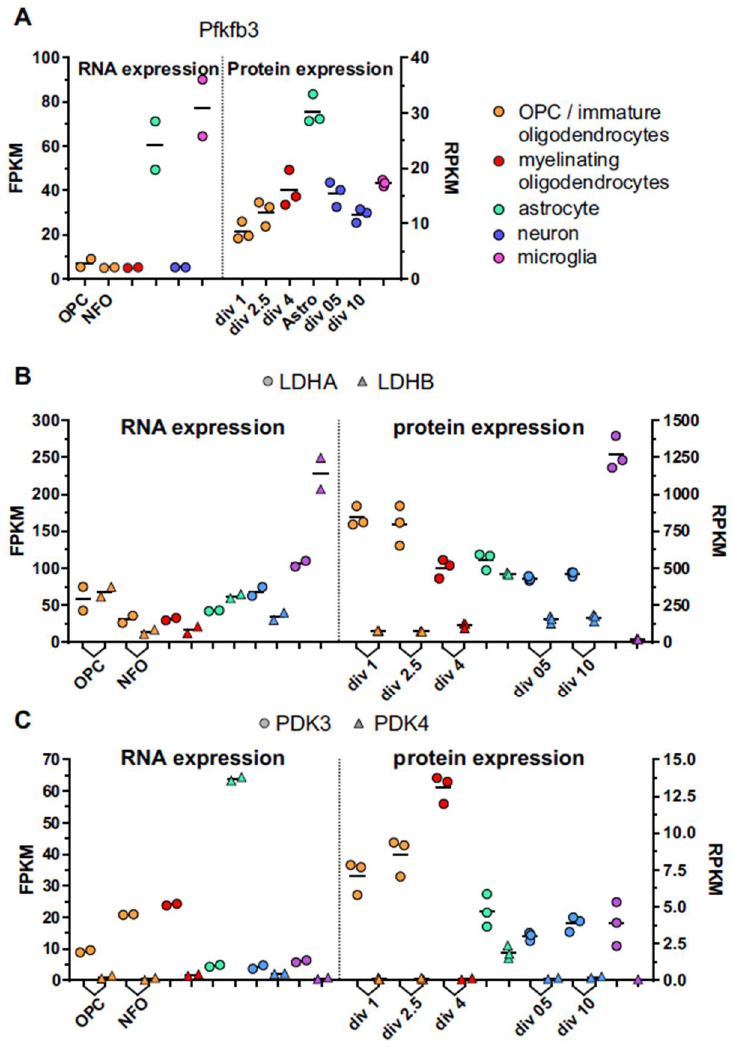
Figure 2. RNA and protein expression of regulatory enzymes involved in glucose and pyruvate metabolism. Transcriptome and proteome data are from Zhang et al. [83] and Sharma et al. [84], respectively. Different cell types are indicated by different colors as explained in the top right panel. The study by Sharma et al. used isolated cells that were cultured and analyzed at different days in vitro (DIV), as indicated. ( A ) Expression of Pfkfb3, a major positive regulator of glycolysis. ( B ) Expression of the two lactate dehydrogenase isozymes LDHA and LDHB. ( C ) Expression of PDK3 and PDK4, which indirectly act as positive regulators of glycolysis by inhibiting pyruvate metabolism in mitochondria. See main text for details.